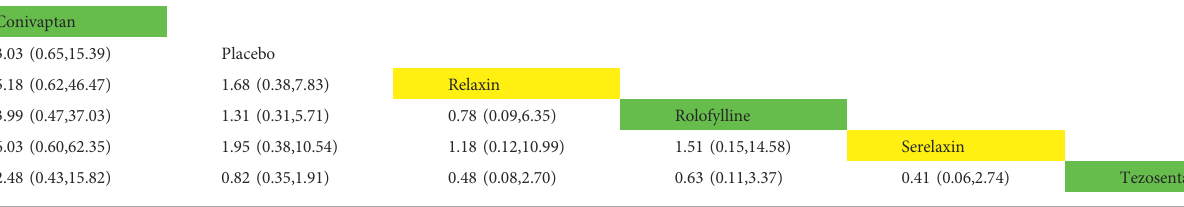
TABLE 5 Direct comparisons between different drugs of the rate of adverse event within 30 days (reported as point estimates of odds ratios or weighted mean differences with 95% credible intervals, with number of studies contributing to network). Among them, those marked as yellow are vasodilators, those marked as green are vasoconstrictors, and those marked as white are placebos.